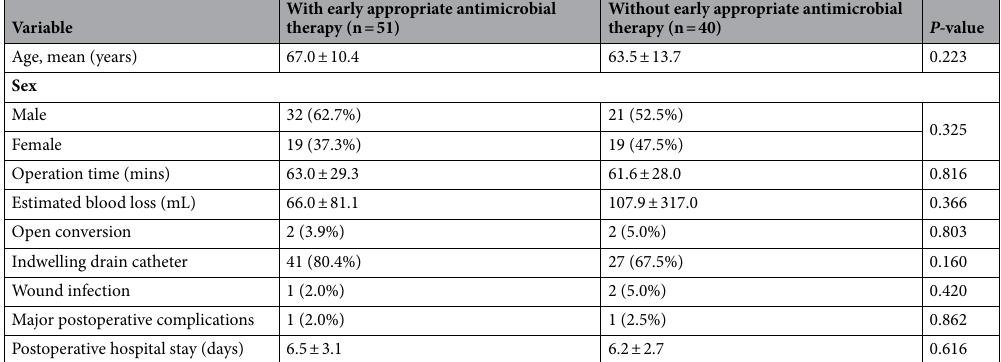
Table 3. Comparative analysis of the perioperative outcomes in grade II acute cholecystitis patients with and without early appropriate antimicrobial therapy. Data are presented as the mean ± standard deviations or numbers with percentages in parentheses unless otherwise